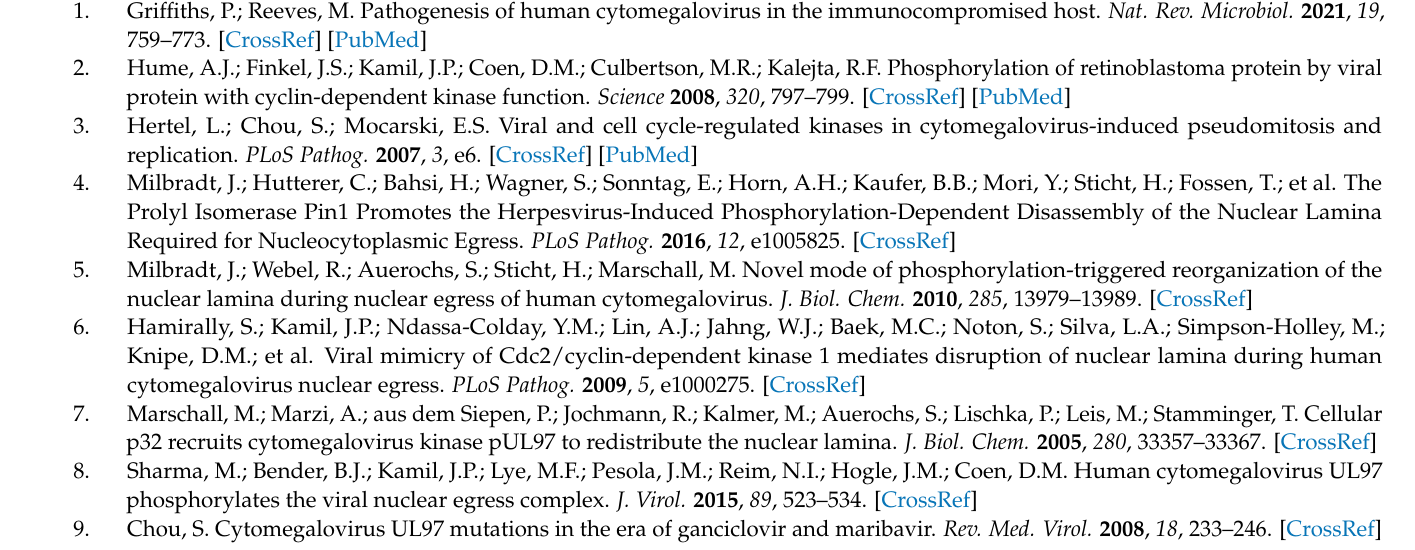
treatment. Figure S3: Dose-dependend effect of 3MB-PP1 on